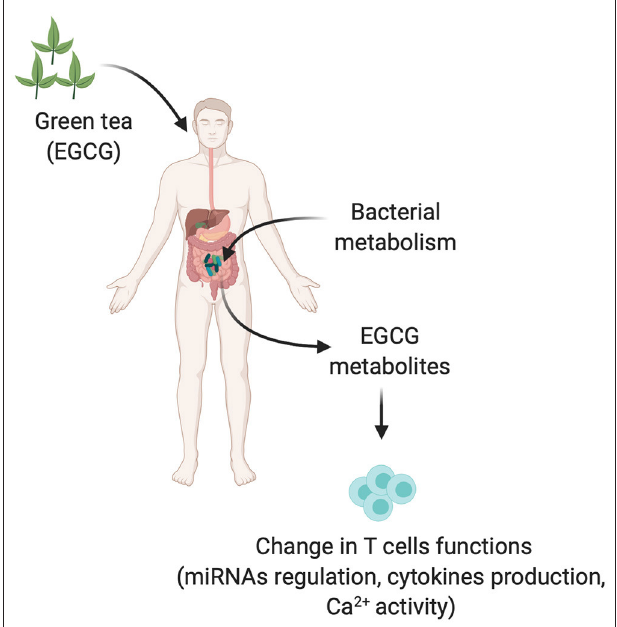
FIGURE 1 | Gut microbiota in modulation of green tea into different metabolites and possible immune T cells dysregulation. EGCG and EGCG derived metabolites produced by gut microbiota could be modifying the effector functions of immune T cells by different mechanisms such as upregulating the miRNAs, cytokine production, or Ca 2 +